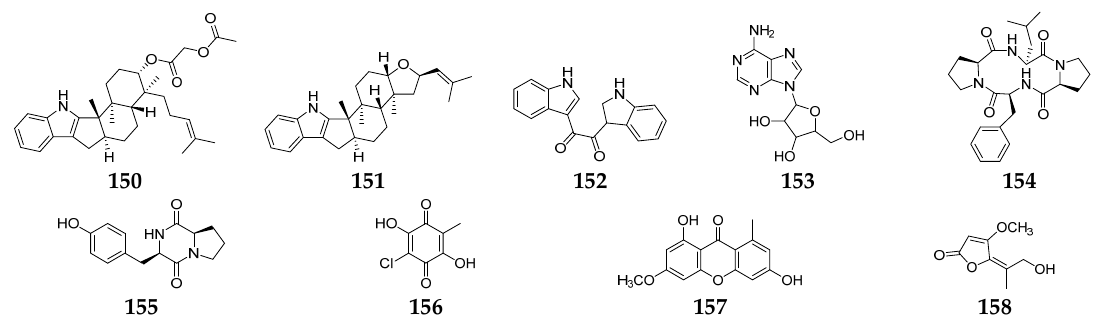
Figure 6. Fusarium -derived antiviral SMs ( 150–158 ).